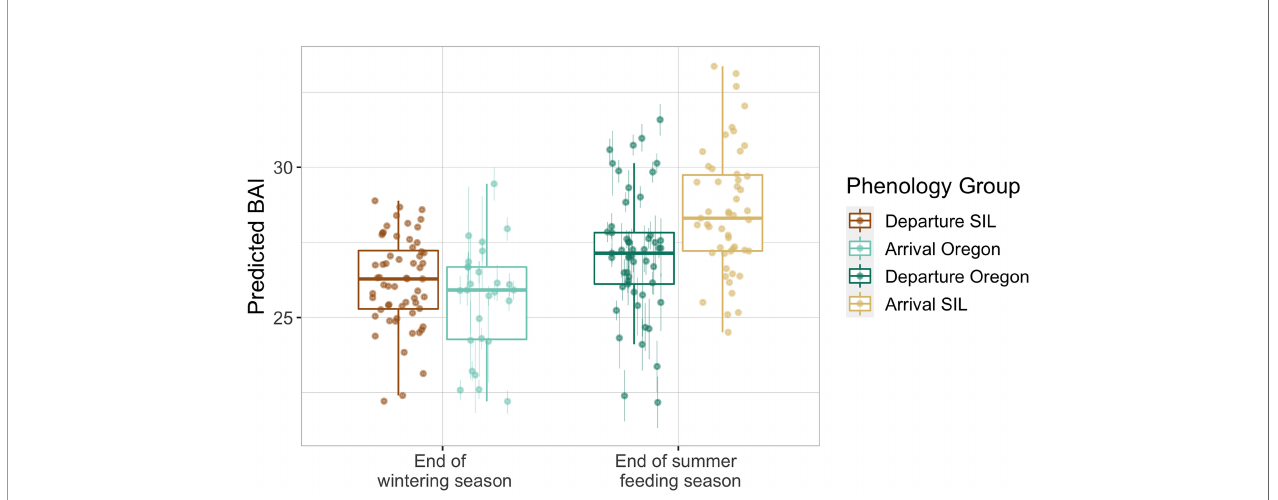
FIGURE 3 | Boxplots illustrating the distribution of predicted Body Area Index (BAI) values of gray whales imaged by UAS in San Ignacio Lagoon (SIL), Mexico and Oregon, USA as produced by the Bayesian statistical model accounting for measurement uncertainty. Data are grouped by phenology group: End of summer feeding season (departure Oregon vs. arrival SIL) and End of wintering season (arrival Oregon vs. departure SIL). The group median (horizontal line), interquartile range (IQR, box), maximum and minimum 1.5*IQR (vertical lines), and outliers (dots) are depicted in the boxplots. The overlaid points represent the mean of the posterior predictive distribution for BAI of an individual and the bars represent the upper and lower bounds of the 95% HPD interval.